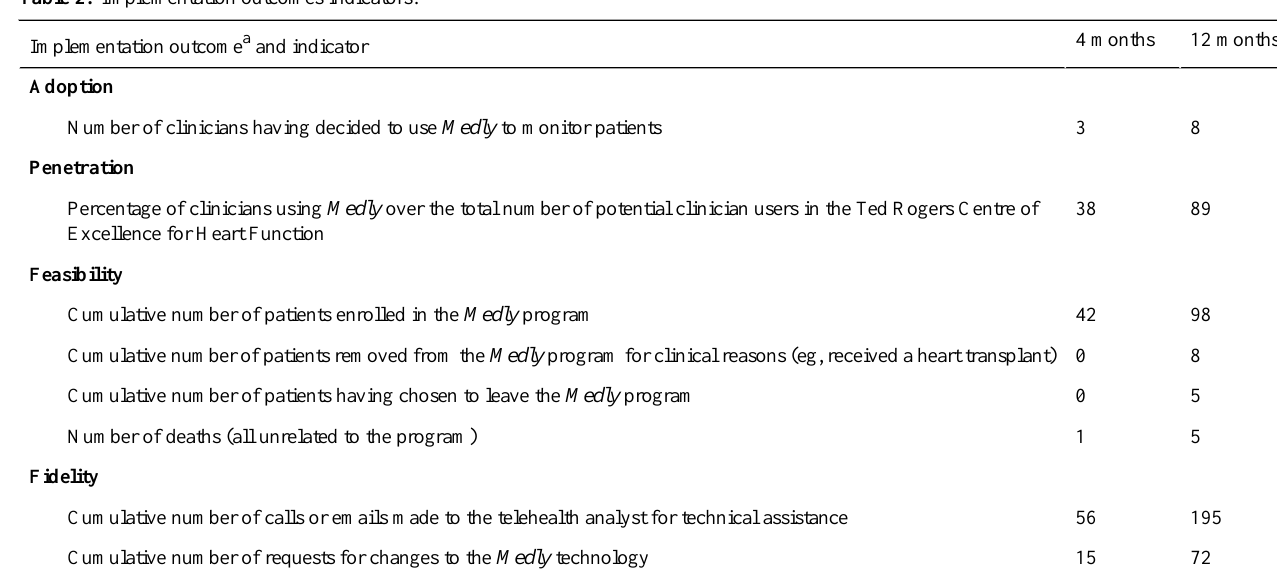
Table 2. Implementation outcomes